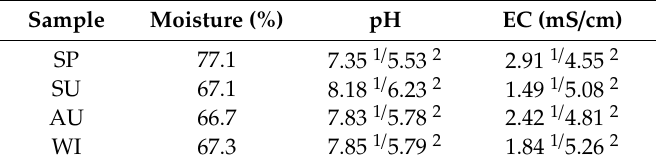
Table 1. Physicochemical parameters on the leachates of the four sludges tested.